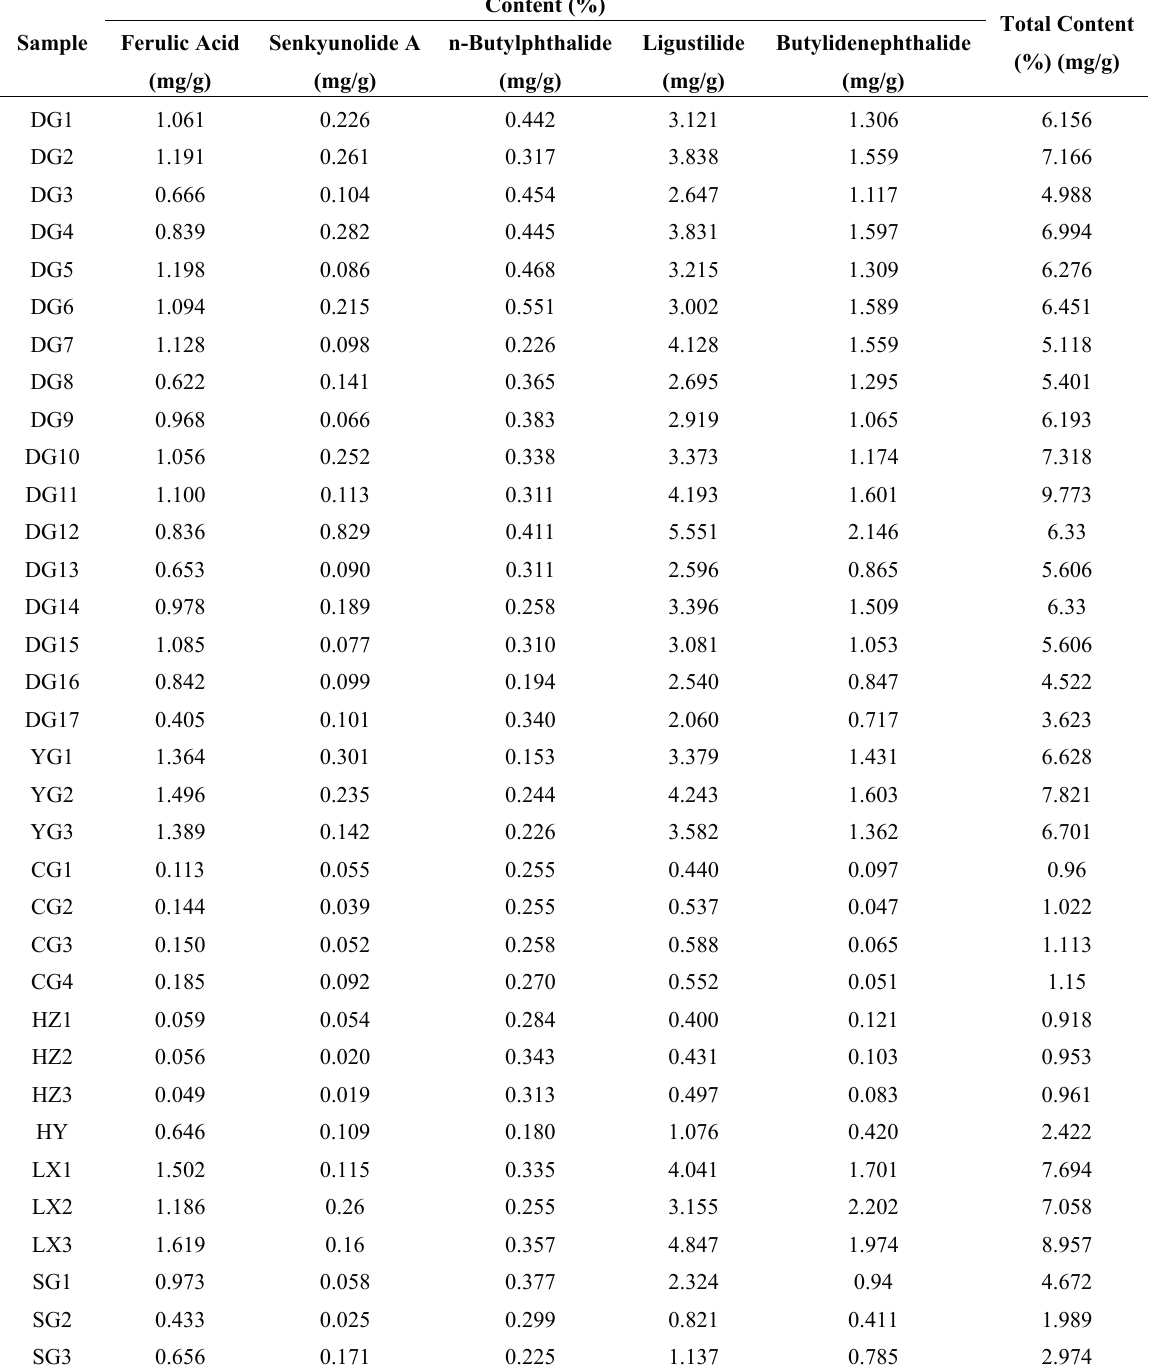
Table 2. Contents of ferulic acid and phthalides in Angelica